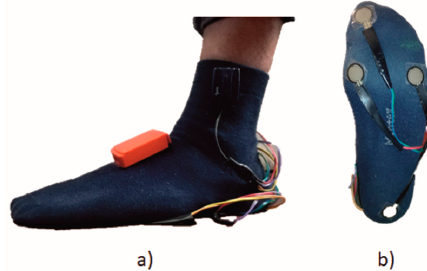
Figure 1. Sensors positioning on subject. ( a ) Position of IMU on participant’s foot; ( b ) position of footswitches under participant’s foot.